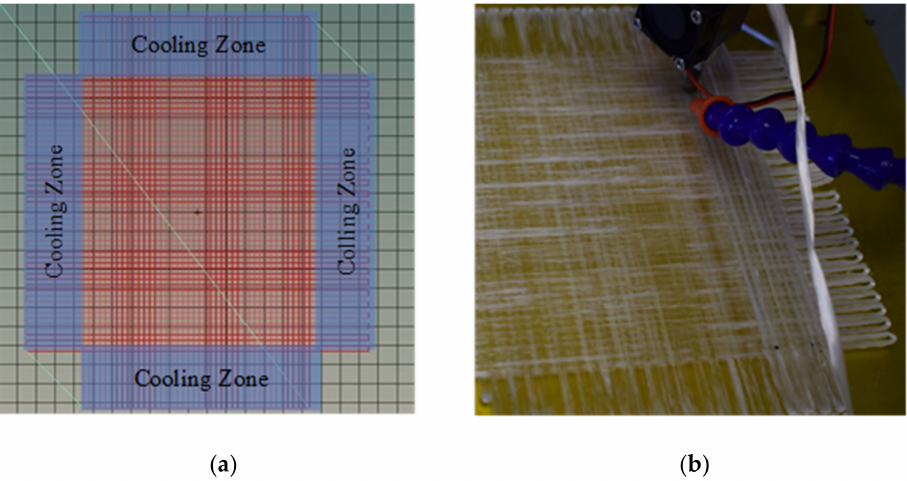
Figure 14. Manufacturing of a continuous fiber laminate; ( a ) G-code with cooling zones and ( b ) the manufactured